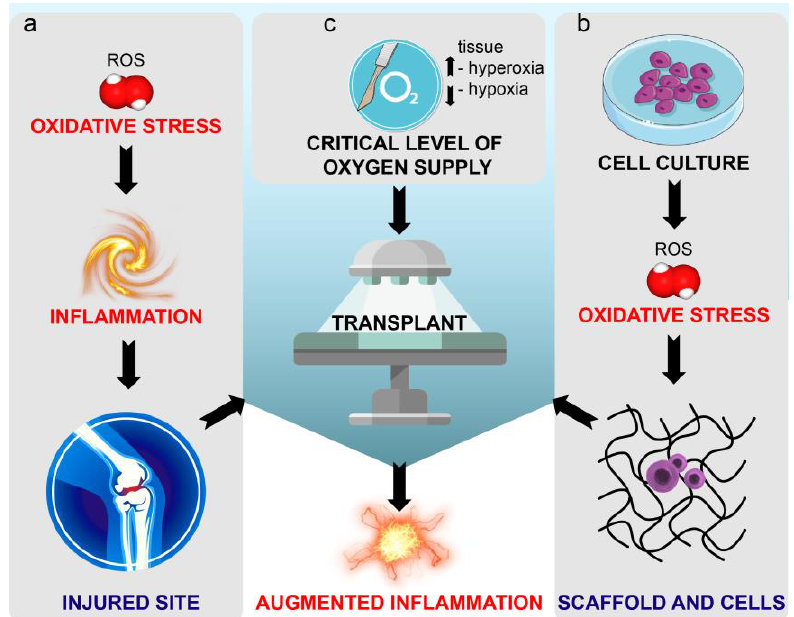
Figure 1. Schematic representation of the issues afflicting medical tissue engineering. ( a ) The injured site receiving the transplant is characterized by oxidative stress and pre-existing inflammation. ( b ) During cell cultures, the generation of reactive oxygen species (ROS) triggers harmful oxidative stress for cells included in biomaterial scaffold and intended for transplant. ( c ) During the transplantation, both the injury deriving from surgery and the oxygen supply can change tissue physiological oxygen levels. Taken together, the aforementioned conditions may augment inflammation and decrease the chance of success of tissue engineering.